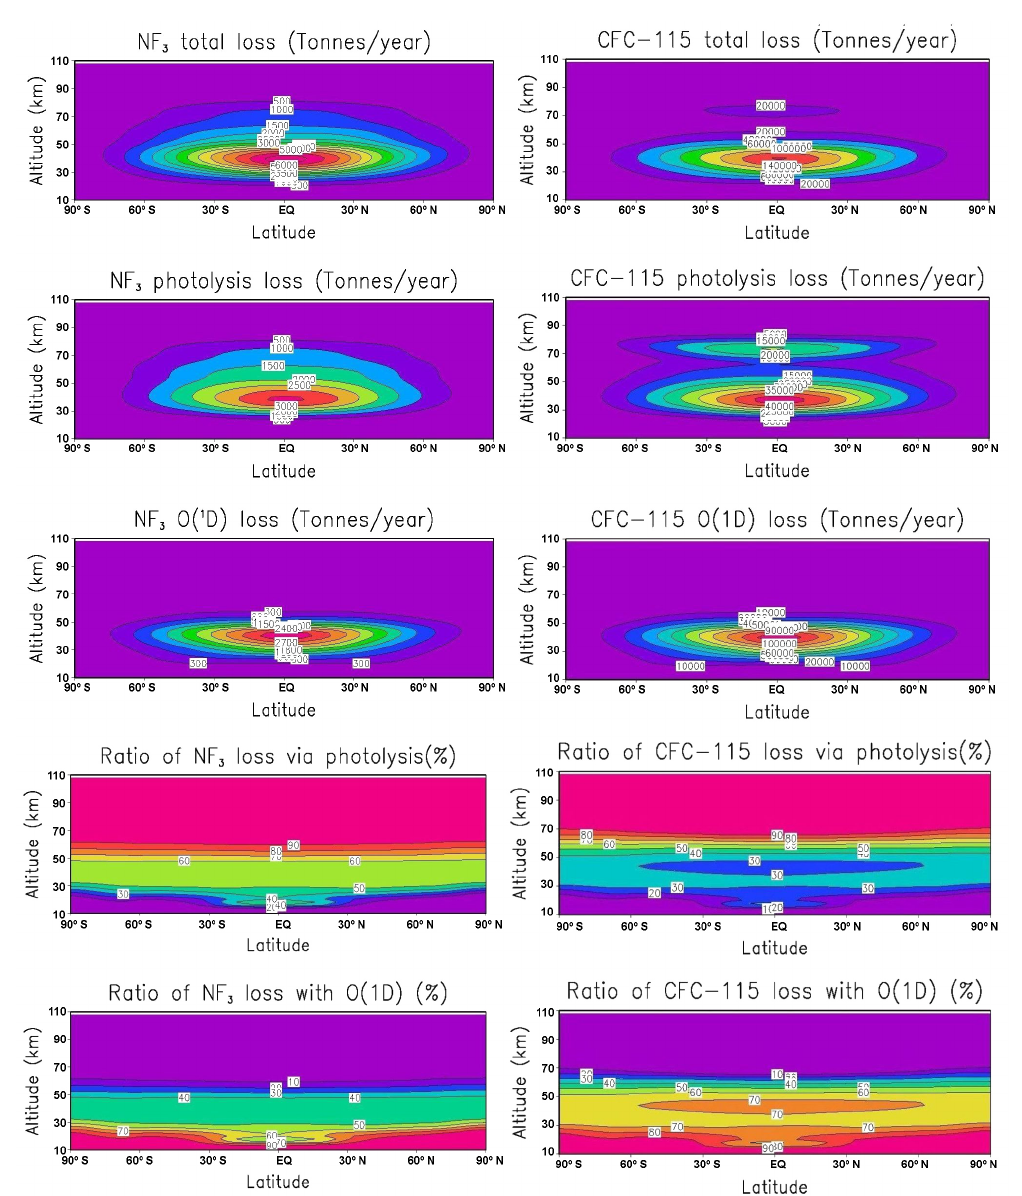
Figure 4. Atmospheric loss rates of the total NF 3 (left-hand panels) and total CFC-115 (right-hand panels) showing the total loss rate, loss rates via photolysis and reaction with O( 1 D), and the percentage contributions to the total loss rates, in the thirteenth year of the